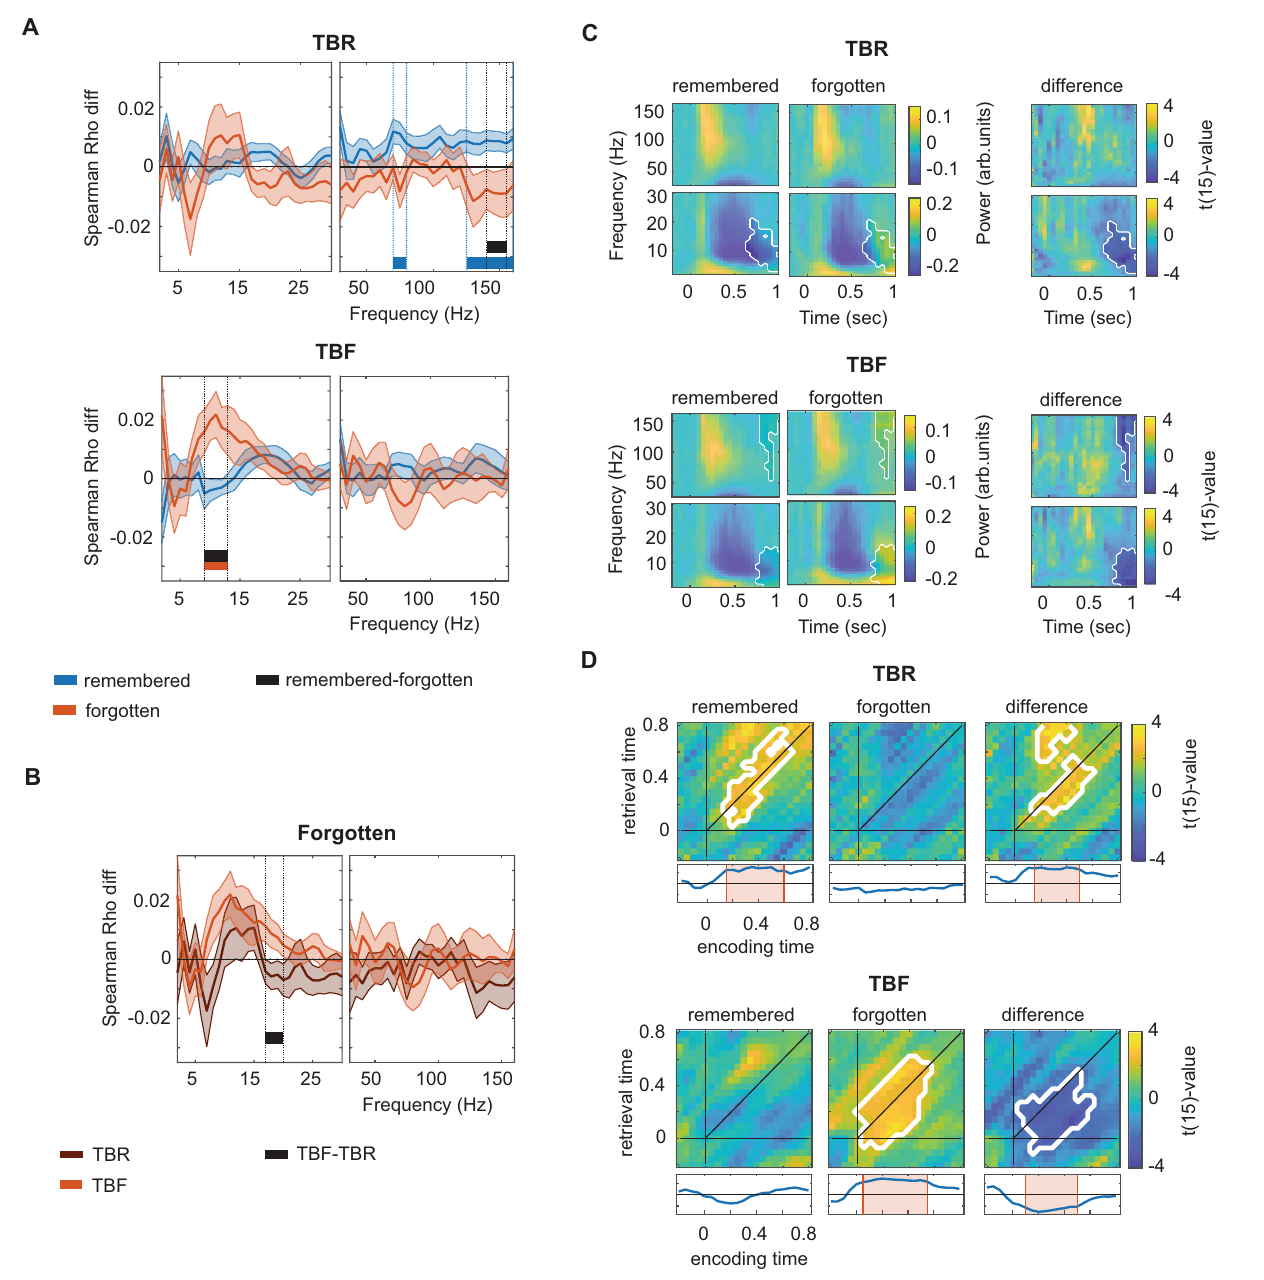
Fig. 4 Differential encoding-retrieval similarity of remembered and forgotten items. A Encoding-retrieval similarity for all to-be-remembered (TBR; top) and to-be-forgotten (TBF; bottom) items, separately for words that were later remembered (blue) or forgotten (orange) based on LTC power ( n = 16). Blue, orange, and black lines indicate signi fi cant item-speci fi c encoding-retrieval similarity of remembered items, forgotten items, and their difference, respectively. Shaded error bars indicate the standard error of the mean. The direct contrast between intentionally vs. incidentally forgotten items (i.e., TBR forgotten vs. TBF forgotten) is separately displayed ( B ). C Time-frequency responses during retrieval (averaged across all lateral temporal channels) for remembered and forgotten TBR (top) and TBF (bottom) words. Alpha/beta power was signi fi cantly higher for forgotten words in a late window (white outline). D Time-shifted encoding-retrieval similarity analyses showed similar patterns as the main analyses. The white outline indicates signi fi cance (cluster-corrected for multiple comparisons). Insets at the bottom represent the time windows at which effects are signi fi cant when encoding-retrieval similarity is based on the same encoding and retrieval time. Source data are provided as a Source Data fi